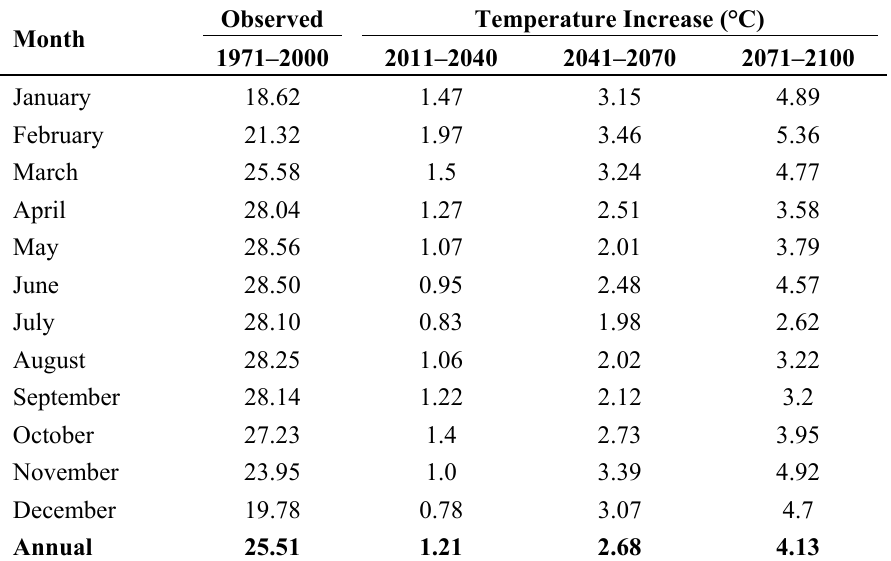
Table 4. Average temperature increase (°C) for Bangladesh relative to